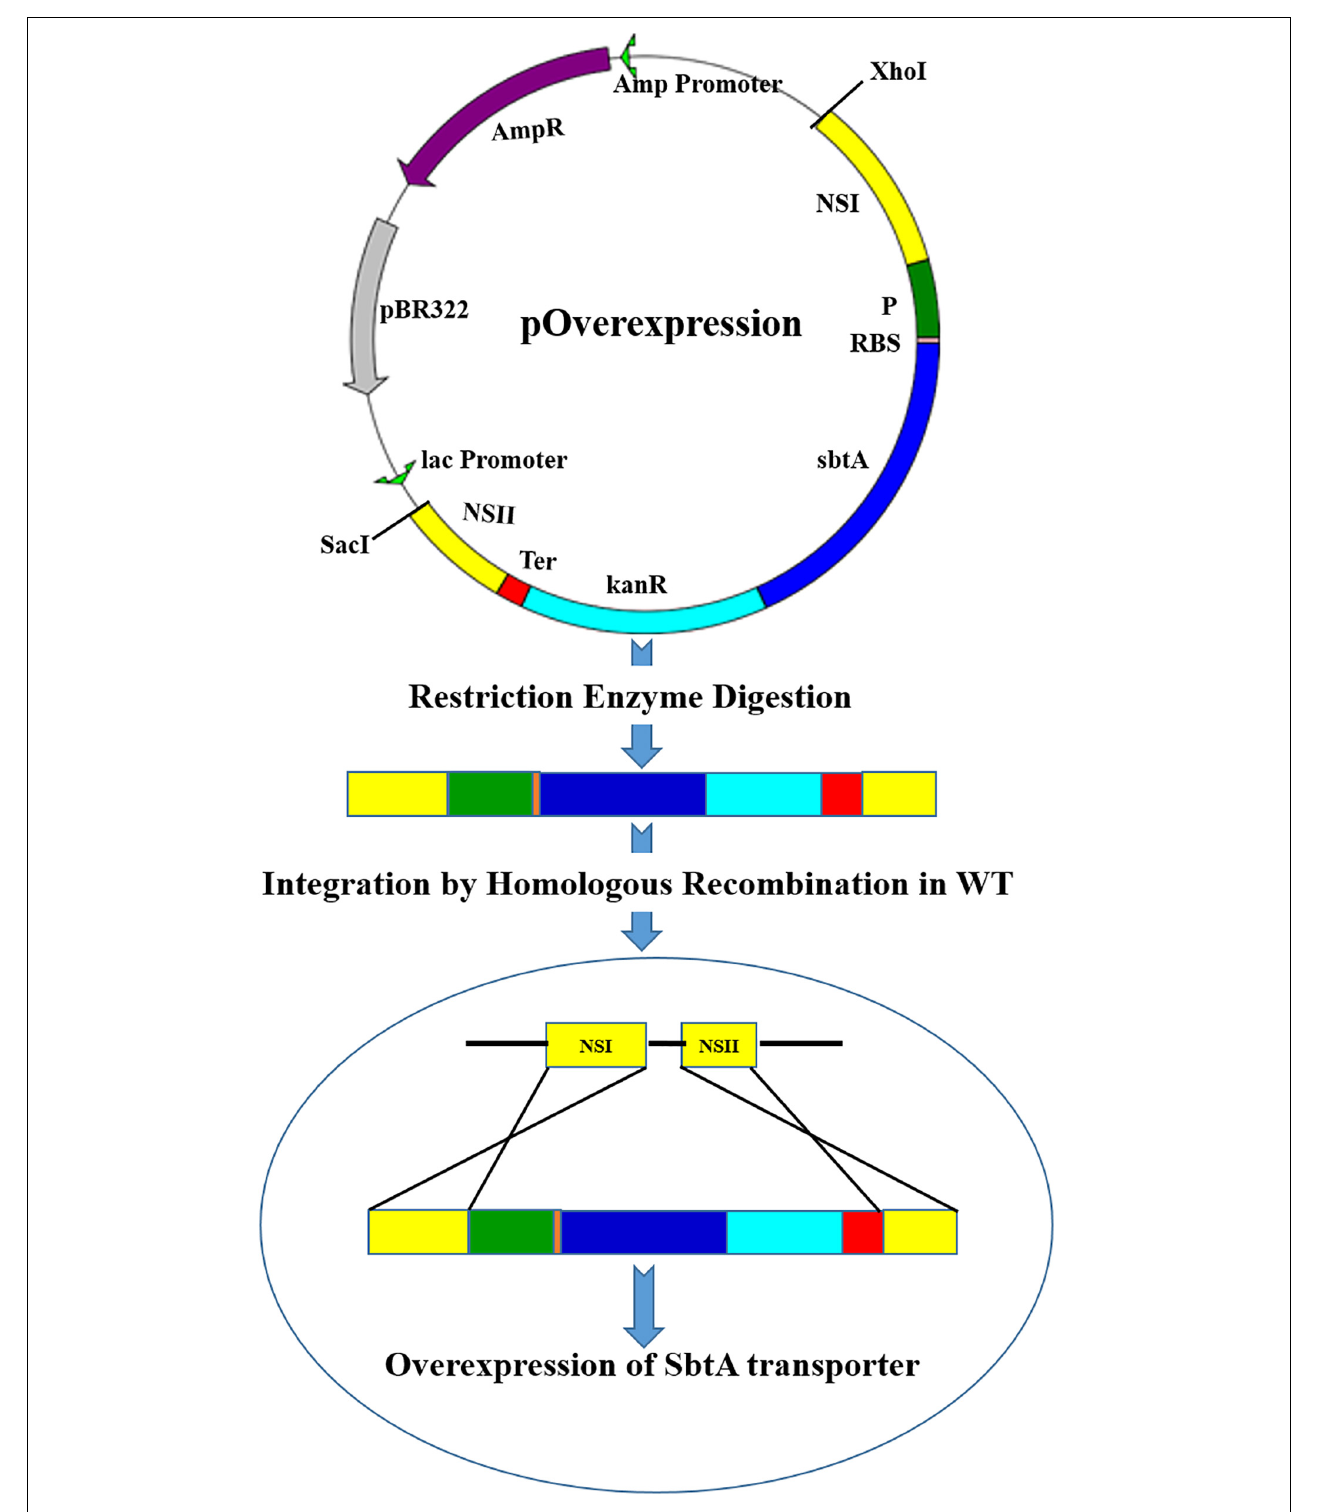
FIGURE 1 | A diagram showing integration of the gene cassettes into the genomic DNA of PCC 7002 through homologous recombination. The vector pOverexpression shows a generalized plasmid for the overexpression of SbtA with different promoters and RBSs sequences. NSI (neutral site I), P (Promoter), RBS (ribosome binding site), sbtA (gene coding for sodium dependent bicarbonate transporter SbtA), kanR (kanamycin resistance gene), Ter (terminator), and NSII (neutral site II).